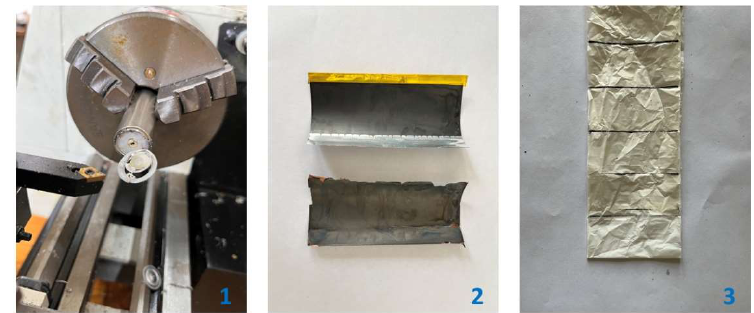
Figure 1. Li-ion battery